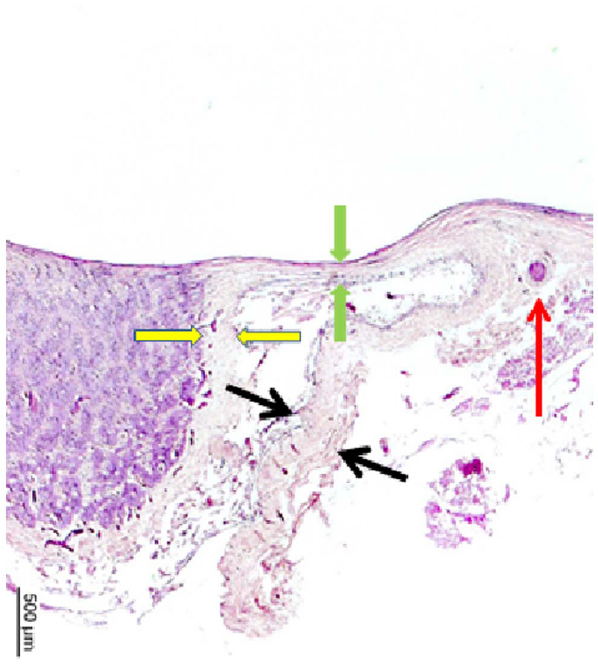
Figure 2. Histophotograph showing the optic nerve head of a highly myopic eyes with the peripapillary arterial circle of Zinn-Haller (red arrow), located the merging point of the dura mater (black arrows) with the scleral at the end of the peripapillary scleral flange (between green arrows), the pia mater and the peripapillary ring as the continuation of the pia mater (between yellow arrows). (Table 1). Within this non-highly myopic non-glaucomatous group, the distance ZHAC to peripapillary ring was not significantly associated with age ( P = 0.10) nor axial length ( P = 0.84).